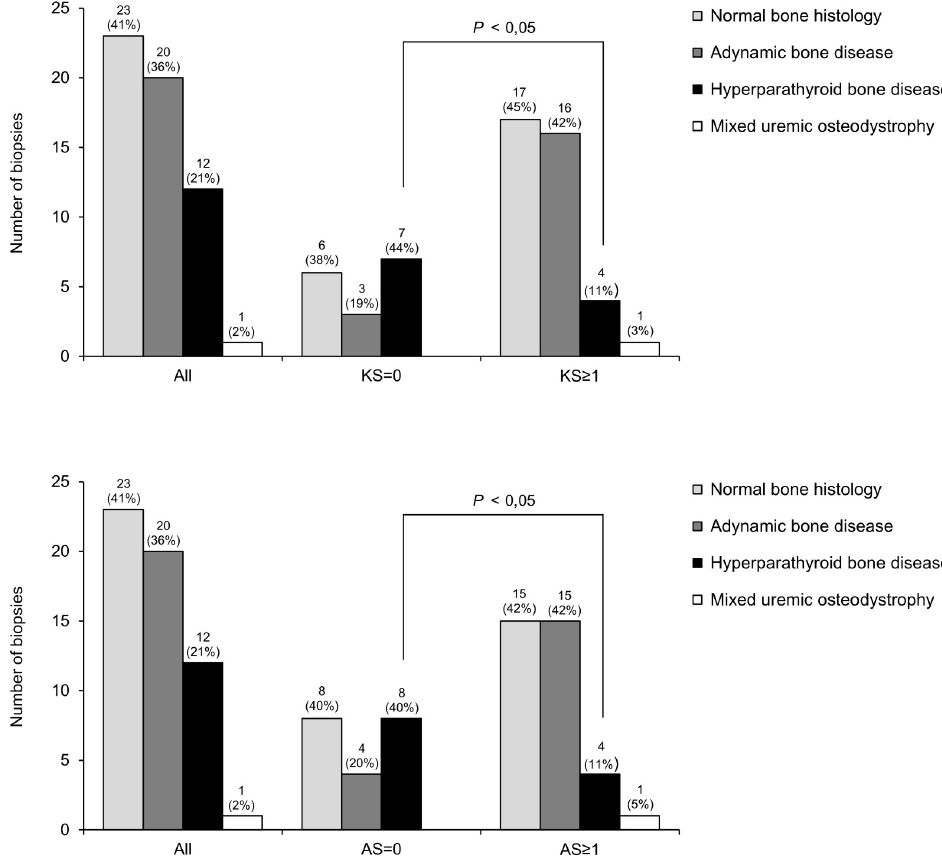
Fig 1. Distribution of bone histological patterns in relation to vascular calcification status.